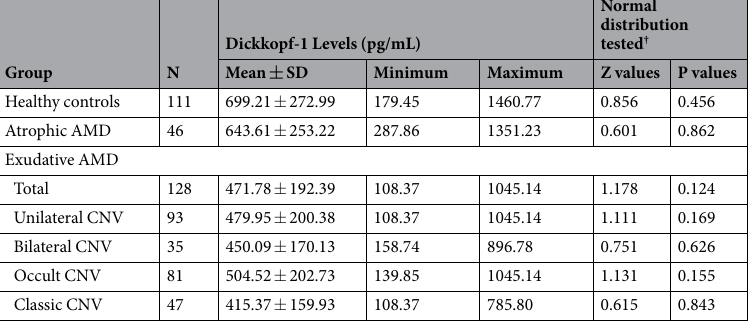
Table 2. Normal Distribution of Dickkopf-1 Levels in Study Subjects. AMD = age-related macular degeneration; CNV = choroidal neovascularization. † Data were tested by one-sample Kolmogorov–Smirnov test and were considered normal distribution when P > 0.05.